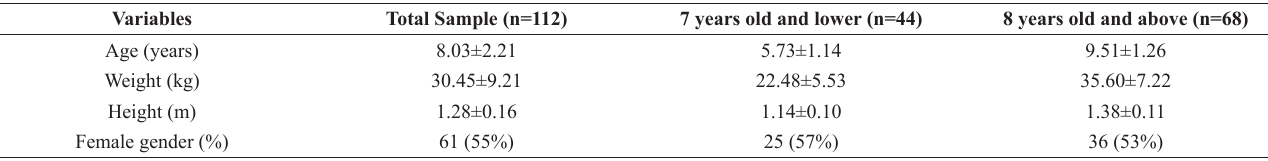
Table 1 - Characterization data of the total sample and by age. Variables Total Sample (n=112)